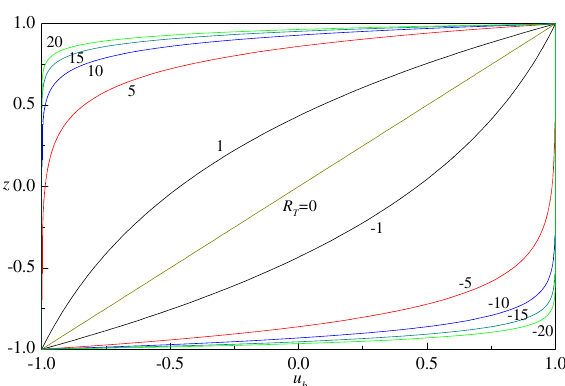
Figure 2. Basic velocity profiles for different values of R T